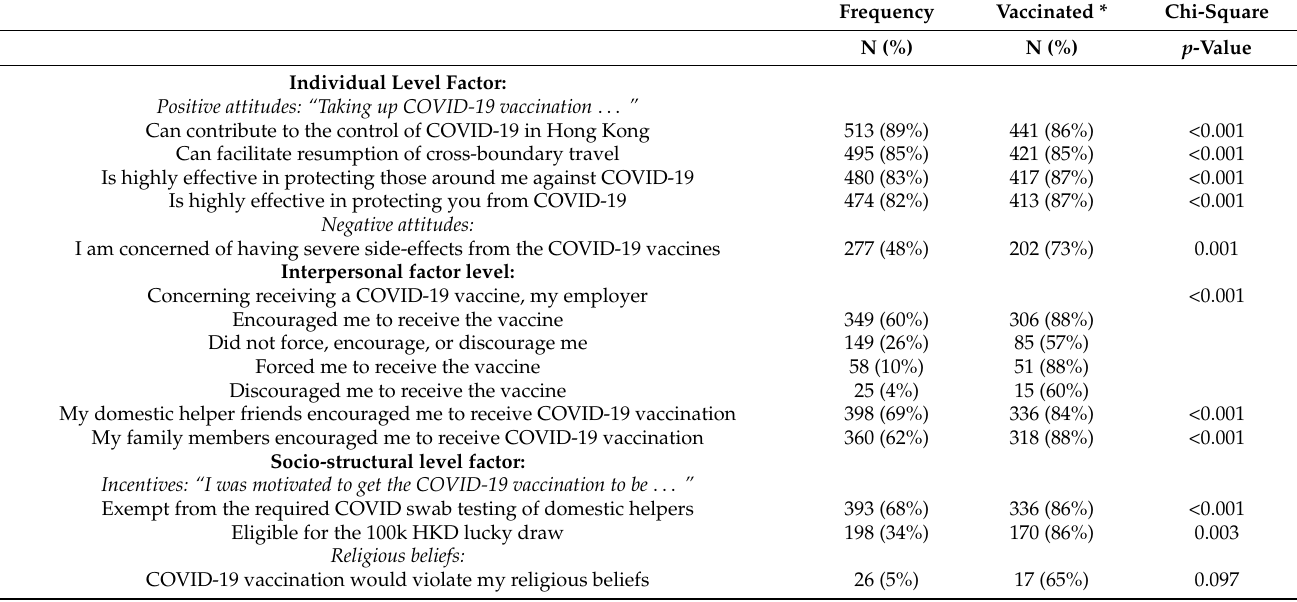
Table 2. Individual, interpersonal, and socio-structural factors related to COVID-19 uptake ( n =